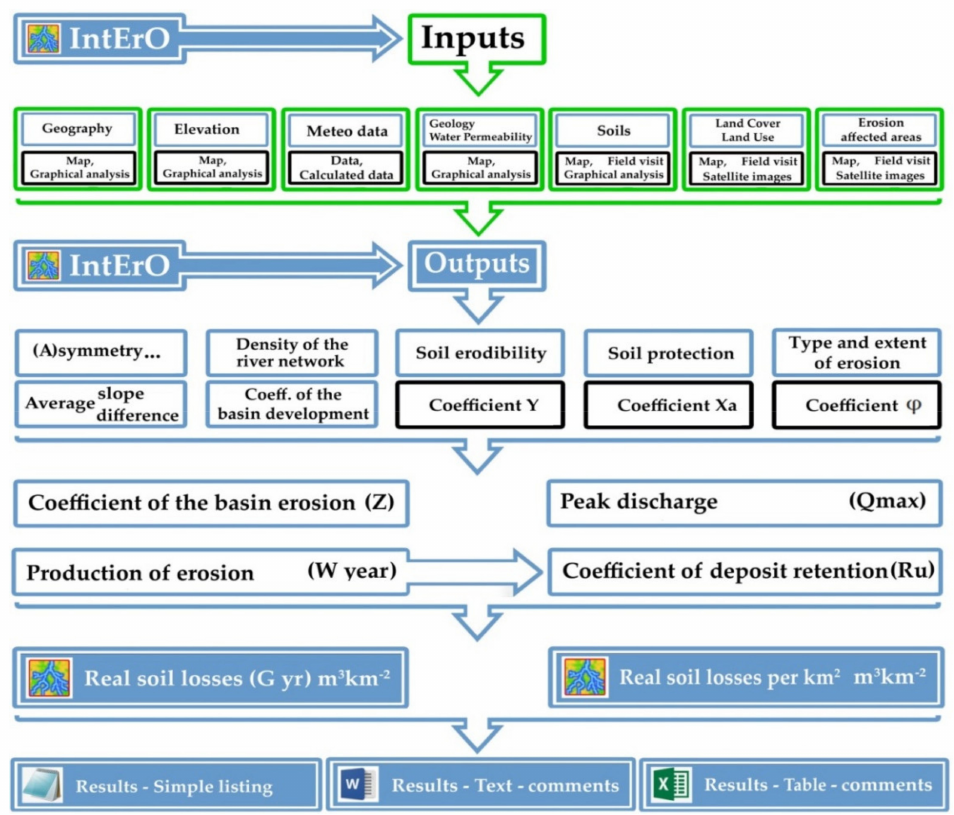
Figure 2. Flow chart of the Intensity of Erosion and Outflow (IntErO) model with the details on key inputs and outputs (revised, based on Spalevic et al. [11]). Table 1. Input data for the IntErO in Talar